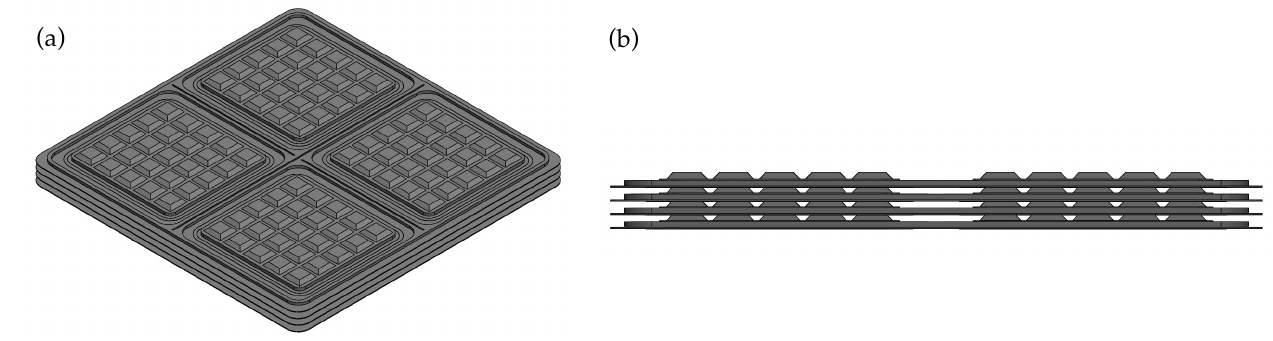
Figure 1. Representative stack of four layers of PCM–air heat exchanger: ( a ) isometric view, ( b ) side view of the assembly.